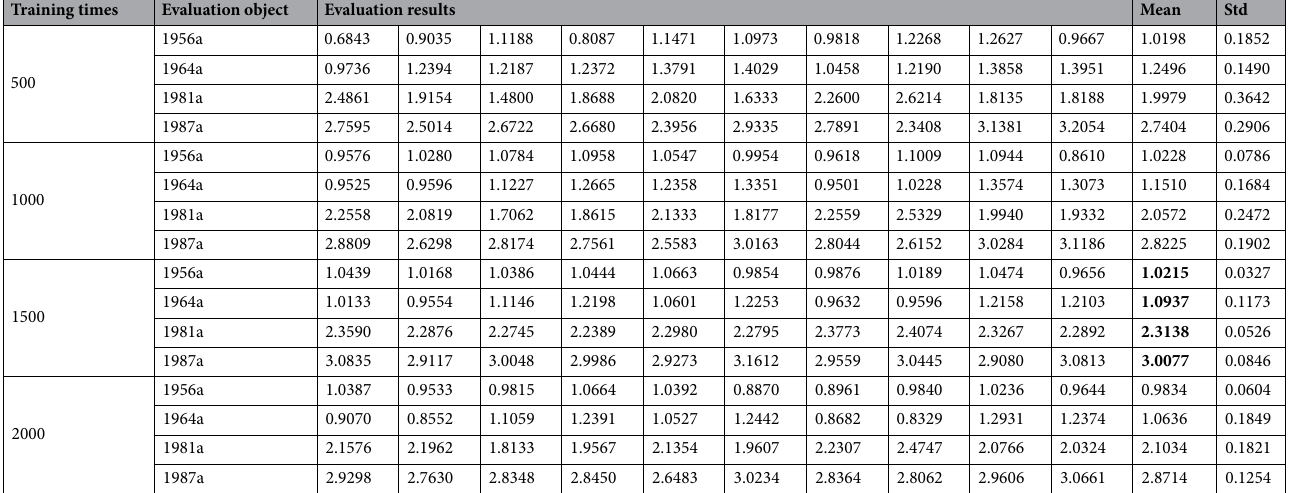
Table 5. The evaluation results of T–S FNN under different training times under the assumption that each evaluation index is uniformly distributed. Significant values are in [bold].